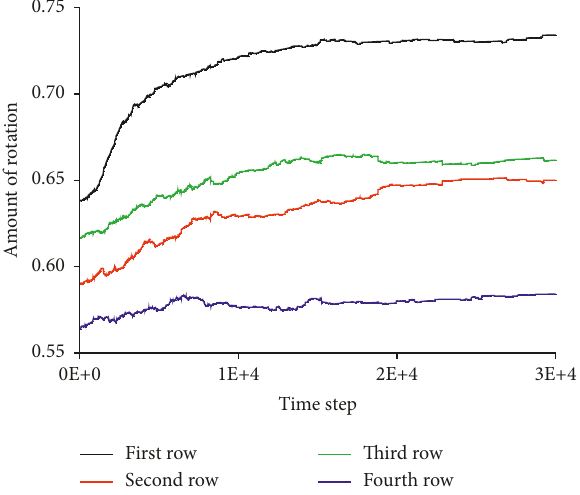
Figure 25: Rotation variation of particle below the plate.